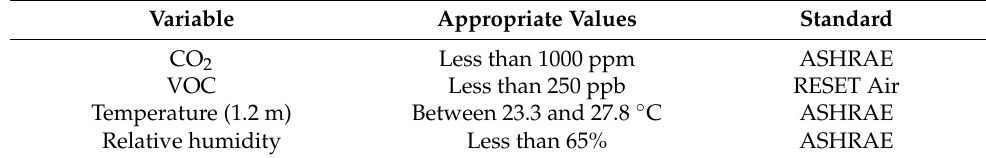
Table 1. Accepted range of values for environmental parameters according to different standards. Variable Appropriate Values Standard CO 2 Less than 1000 ppm ASHRAE VOC Less than 250 ppb RESET Air Temperature (1.2 m) Between 23.3 and 27.8 ◦ C ASHRAE Relative humidity Less than 65%